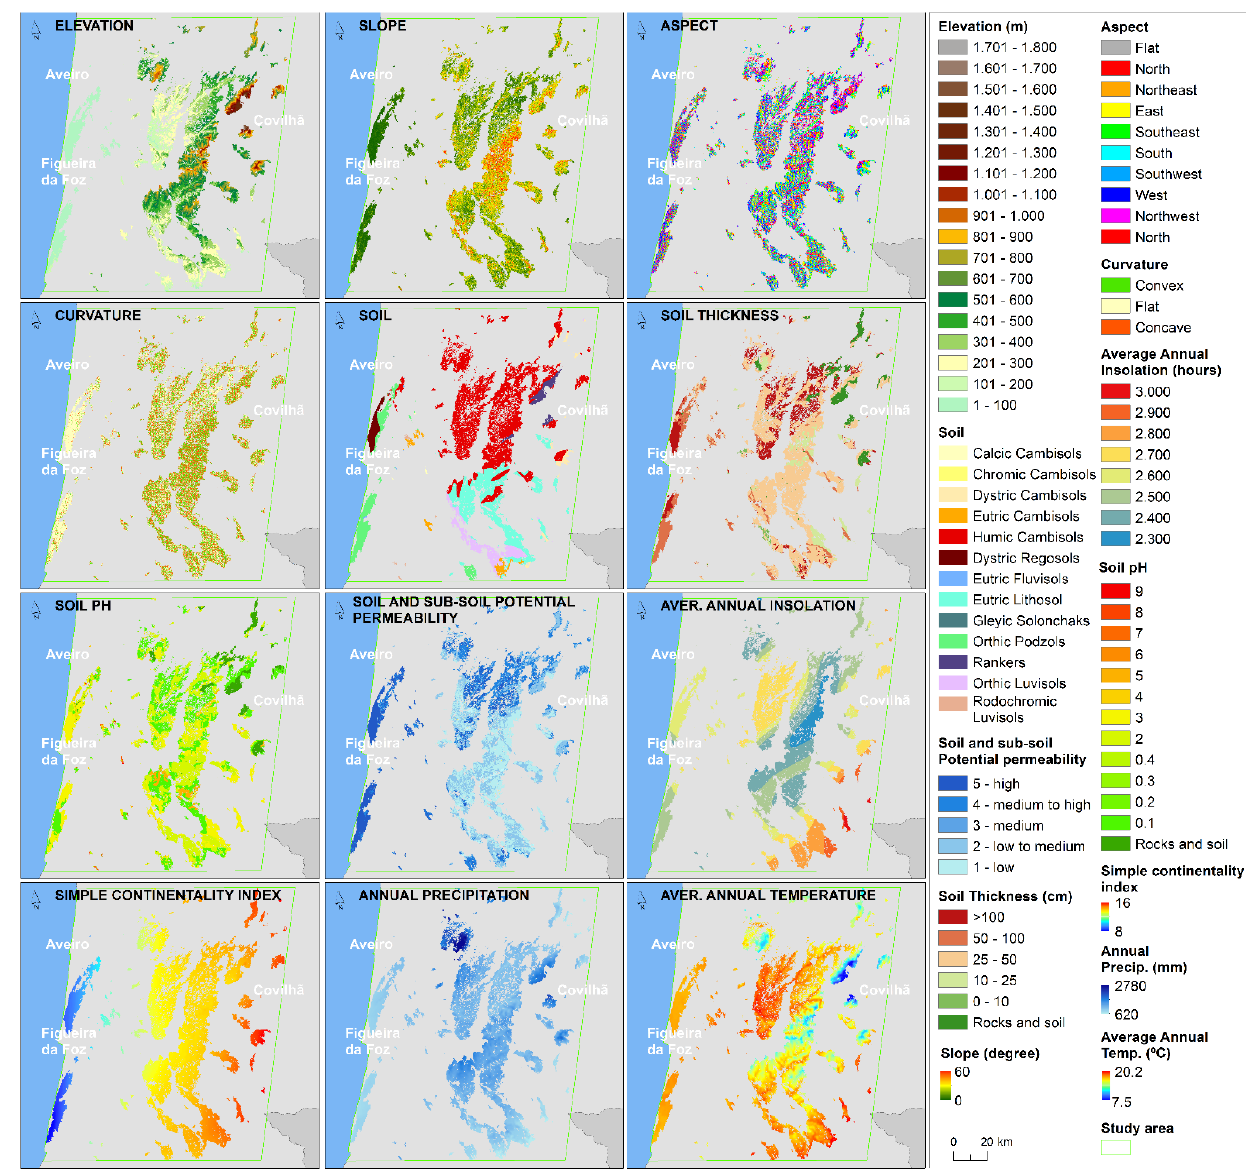
Figure 2. Independent variables used in the modeling of vegetation recovery in burned areas resulting from the wildfires of 2017.